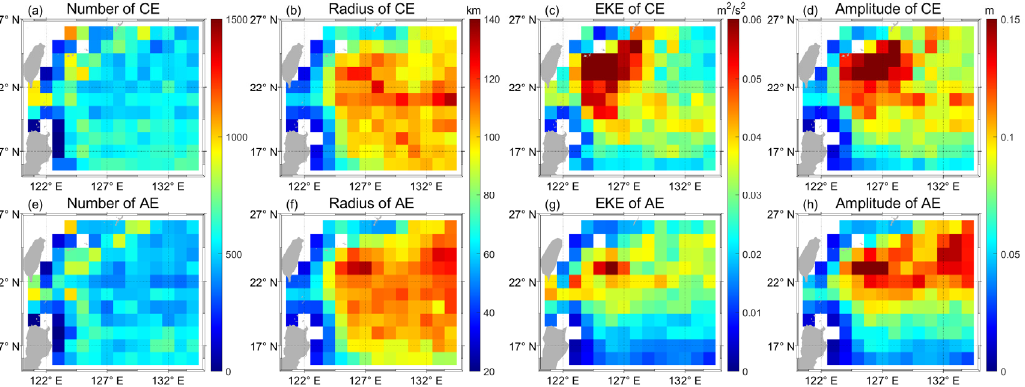
Figure 4. Distributions of eddy number ( a , e ), radius ( b , f ), the EKE ( c , g ), and amplitude ( d , h ). Values in each panel are averaged within 1 ◦ × 1 ◦ grid boxes where the eddy tracks snapshot are located. The boxes whose average depth is less than 300 m are masked to avoid unrealistic values. Upper panels show the distributions of cyclonic eddies (CEs), whereas lower panels show those of anticyclonic eddies (AEs).